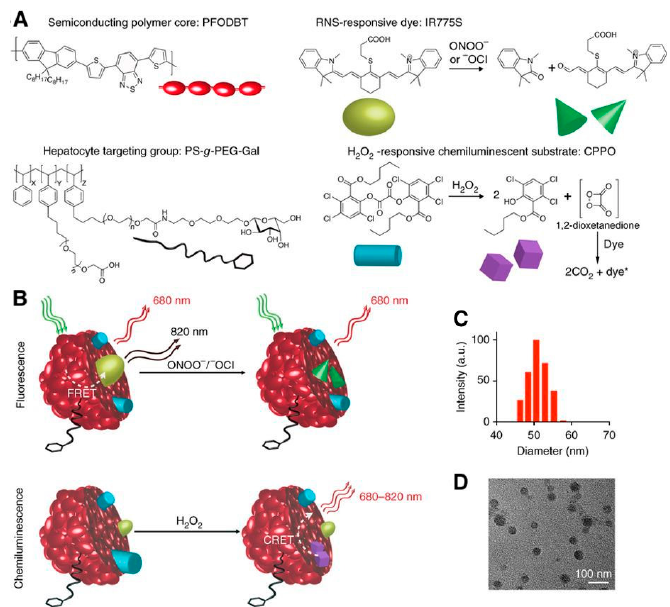
Figure 17. Combined CRET/FRET sensor for in vivo detection of drug-induced hepatotoxicity. ( A ) Molecular components of CF-SPN are the NIR fluorescent semiconducting polymer PFODBT, a PEG-grafted poly(styrene) copolymer conjugated to galactose for hepatocyte targeting (PS-g-PEG-Gal), the H 2 O 2 -specific chemiluminescent substrate CPPO that serves as CRET energy donor, and the FRET acceptor IR775S that degrades after oxidation by ONOO − or − OCl (dark green). PFODBT serves as the CRET energy acceptor and the FRET energy donor. ( B ) Illustration of the mechanism of simultaneous and differential detection of ONOO − or − OCl and H 2 O 2 by CF-SPN. After drug challenge to the liver, CF-SPN report via the chemiluminescent and fluorescent channels the generation of radical metabolites at safe ( left ) and toxic ( right ) drug doses. ( C ) Hydrodynamic diameter distribution of CF-SPN, determined by dynamic light scattering. ( D ) Transmission electron micrograph of CF-SPNs. Adapted with permission from [163]. Copyright 2014, Springer Nature.